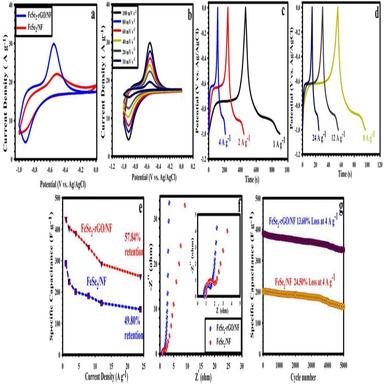
The electrodes' electrochemical performance in a three-electrode system. (a) CV curves of the FeSe2/NF and FeSe2-rGO/NF at 100 mV s1 in 6 M KOH solution. (b) CV curves of the FeSe2-rGO/NF at different scan rates in 6 M KOH solution. (c and d) Galvanostatic charge/discharge curves of the FeSe2-rGO/NF at several current densities. (e) The rate capability of the FeSe2/NF and FeSe2-rGO/NF. (f) Nyquist plots of the FeSe2/NF and FeSe2-rGO/NF. (g) Cycling stability of the FeSe2/NF and FeSe2-rGO/NF at the current d